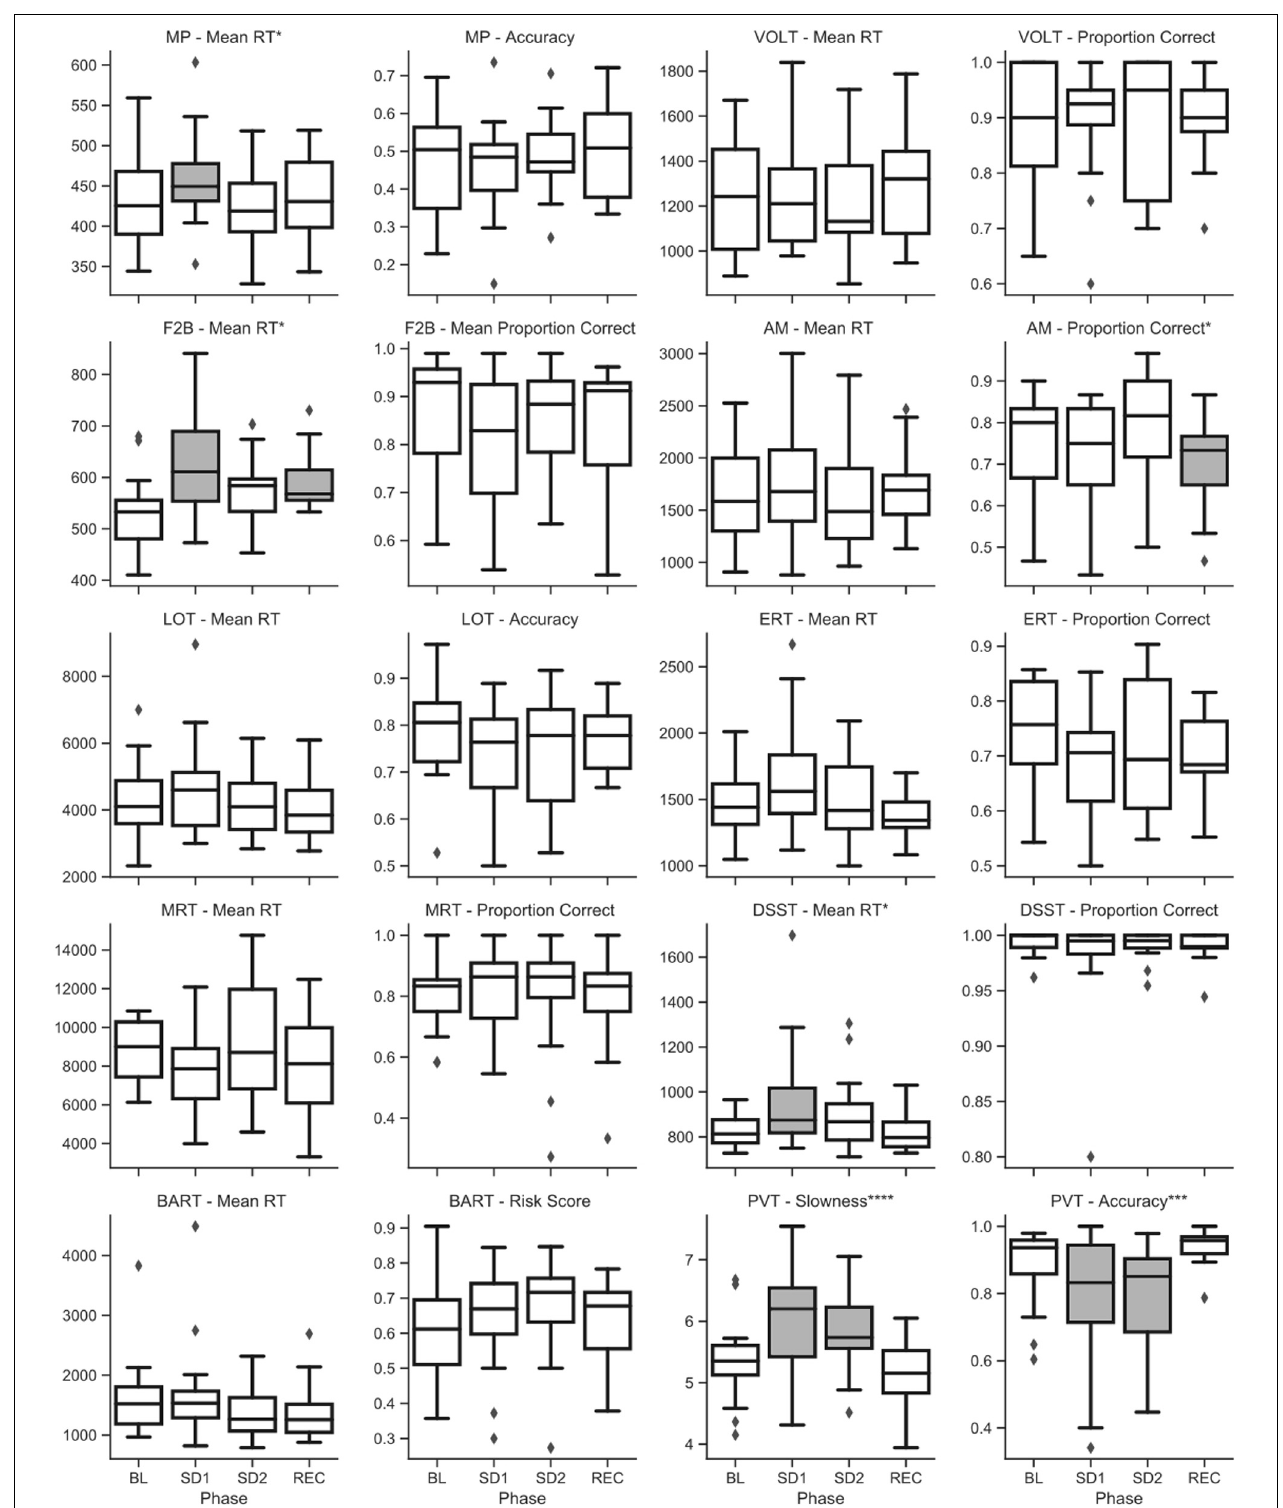
FIGURE 5 | Raw (untransformed) scores across sleep deprivation phases in campaign 2 of HERA on key speed and accuracy metrics of the Cognition battery. Asterisks refer to type-III significance levels of sleep deprivation as a main effect after adjusting for multiple testing with the false discovery rate method (* p < 0.05; ** p < 0.01; *** p < 0.001; **** p < 0.0001). In plots with a significant omnibus effect, data shaded in gray were significantly different from baseline (BL) in a post hoc t -test.